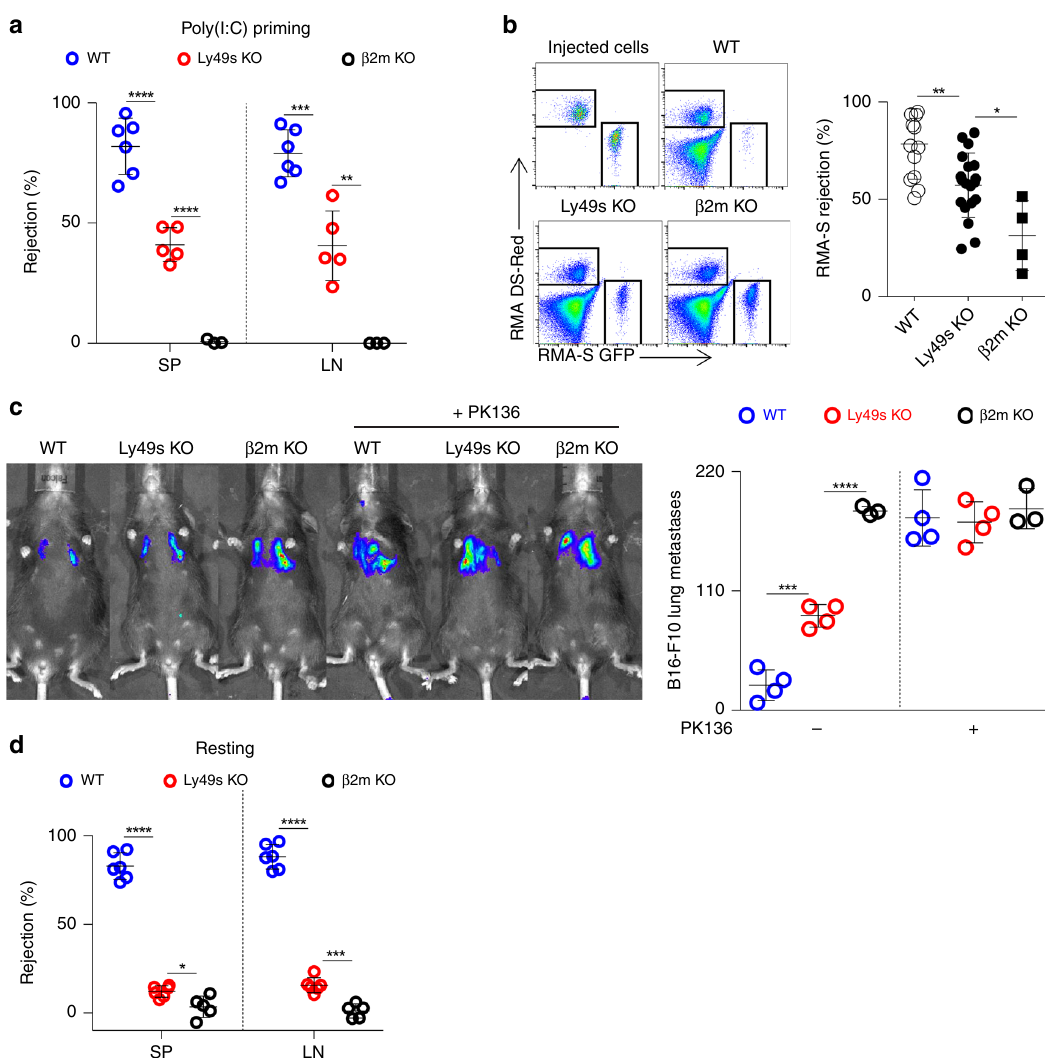
Fig. 3 Ly49 family-de fi cient mice display moderate defect in NK-cell activity in vivo. a In vivo rejection of β 2M-de fi cient splenocytes. High-dose CFSE- labelled β 2M-de fi cient splenocytes were used as donor cells and low-dose CFSE-labelled WT splenocytes were used as an internal control. The percentages of rejected β 2M-de fi cient splenocytes were calculated from the spleen (SP) and lymph nodes (LN) of the indicated mice pre-treated with poly (I:C). b In vivo peritoneal clearance of RMA-S cells. Representative fl ow cytometry plots (left panel) and the percent rejection (right panel) of RMA-S cells injected in the peritoneal cavities of the indicated mice (4 – 19 mice pooled from three independent experiments). c In vivo bioluminescence imaging of pulmonary metastases (left panel) and tumour nodules (right panel) on the lungs of the indicated mice treated with ( + ) or without ( − ) anti-NKR-PR1 antibody at 14 days after the B16-F10 cells inoculation. d Similar to ( a ), but the percentages of rejected β 2M-de fi cient splenocytes were calculated from spleen (SP) and Lymph nodes (LN) of indicated mice without poly(I:C) treatment and were checked at 48 h post injection. Each symbol represents an individual mouse. Data shown represent two ( c ) or at least three ( a , d ) independent experiments. Mean ± SD is shown. * p < 0.05, ** p < 0.01, *** p < 0.001 and **** p < 0.0001. Unpaired Student ’ s t -tests (two-tailed) was used to calculate these values. Source data are provided as a Source Data fi